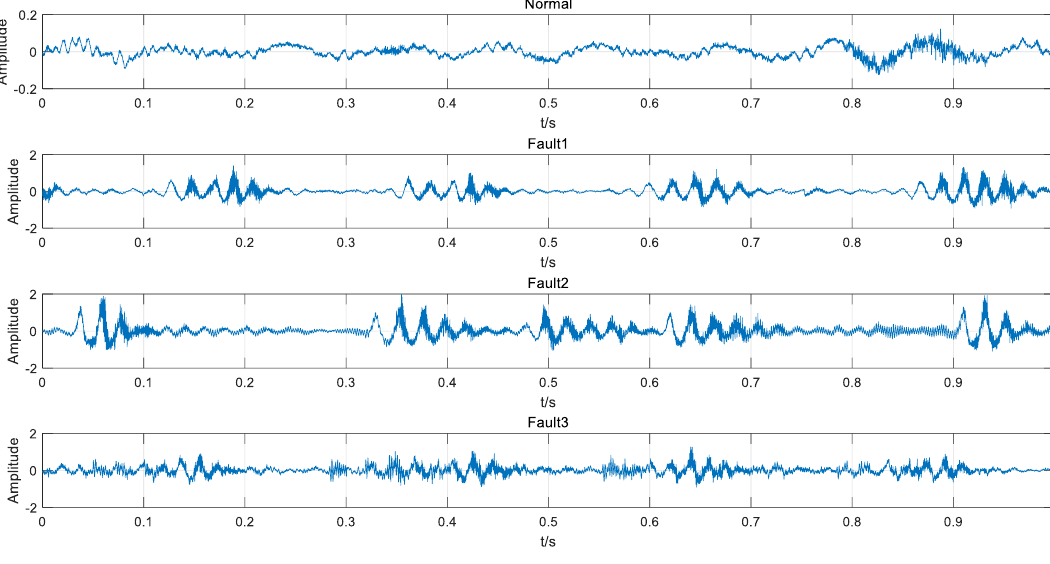
Figure 12. Examples of bogie signals. Table 4. Datasets of bogie fault diagnosis.